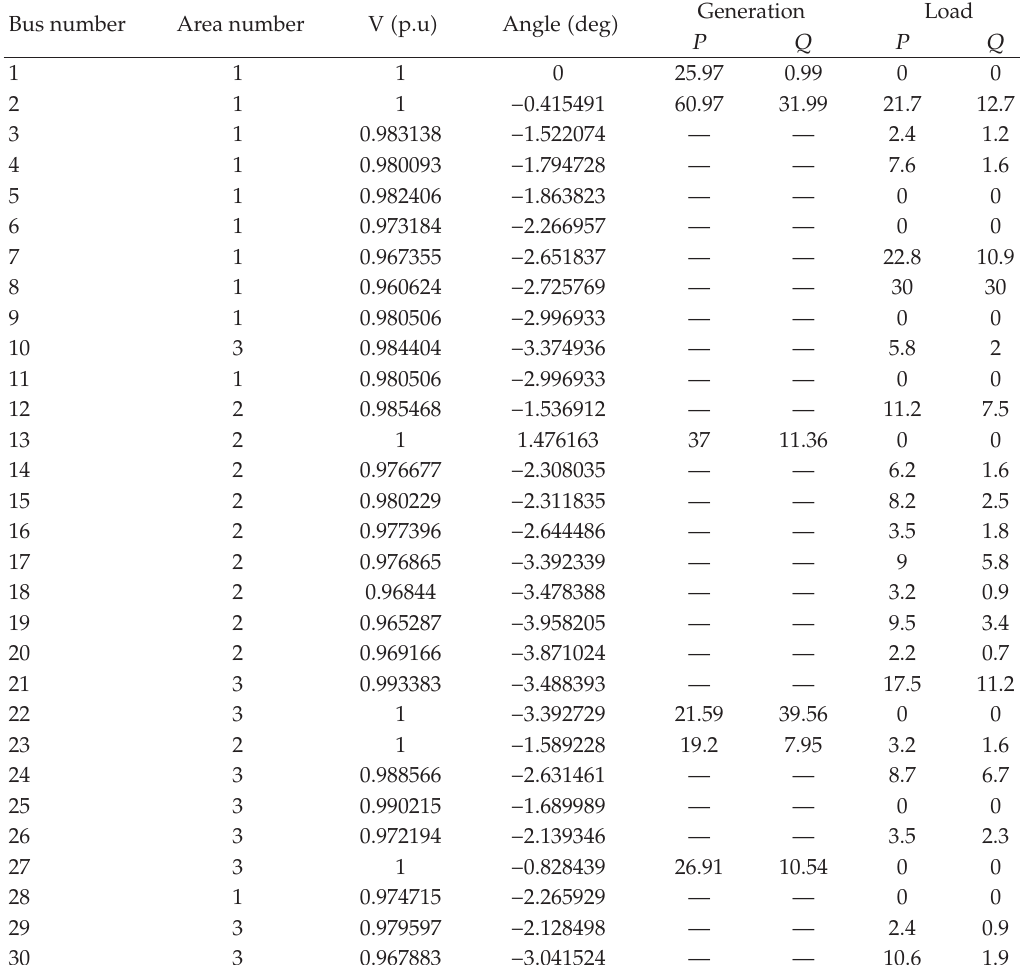
Table 1: Base case load